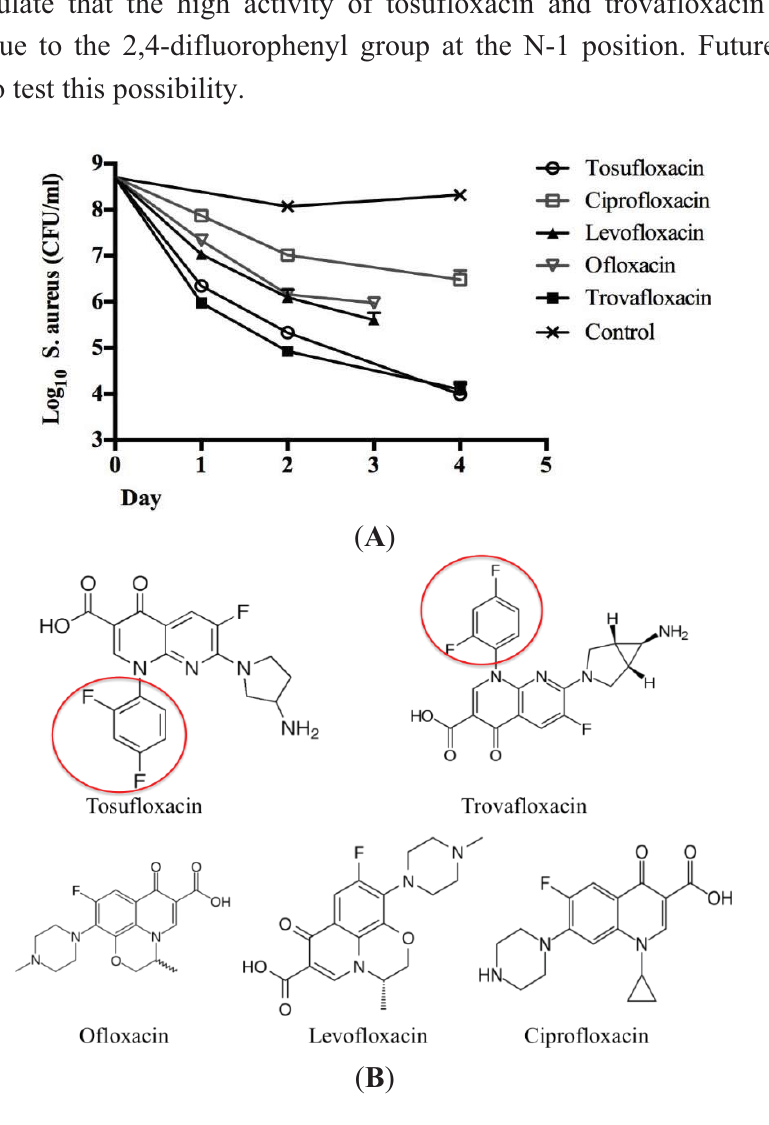
Figure 4. Comparison of the structure and activity of tosufloxacin with the other quinolone drugs. ( A ) The activity of quinolone drugs (10 μM) against S. aureus persisters. S. aureus stationary phase culture was treated with ofloxacin (10 μg/mL) for 4 h to enrich persisters followed by treatment with different quinolone antibiotics. The bacterial viability was determined at different times by CFU count; ( B ) Structures of tosufloxacin and the other quinolone antibiotics. Tosufloxacin and trovafloxacin that have high activity against persisters both contain the 2,4-difluorophenyl group at the N-1 position, which is highlighted by the red circle and is absent in other less active